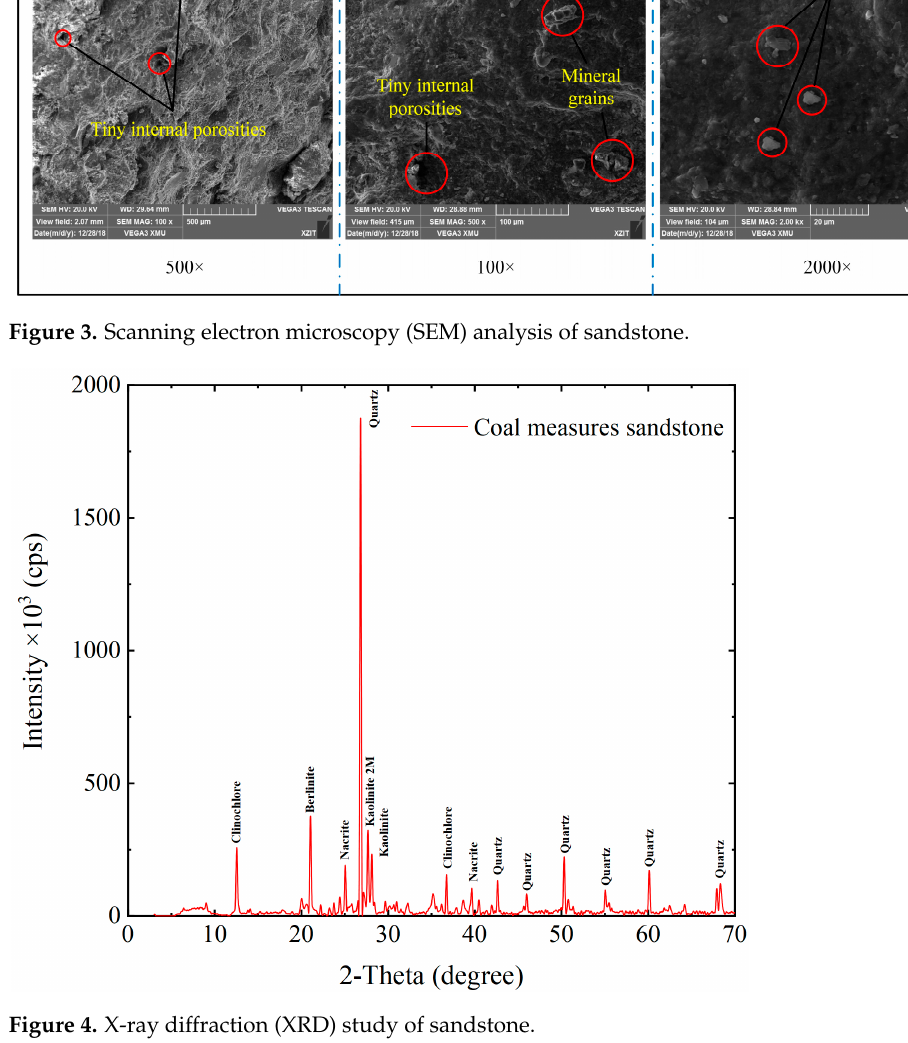
Figure 4. X-ray diffraction (XRD) study of sandstone.